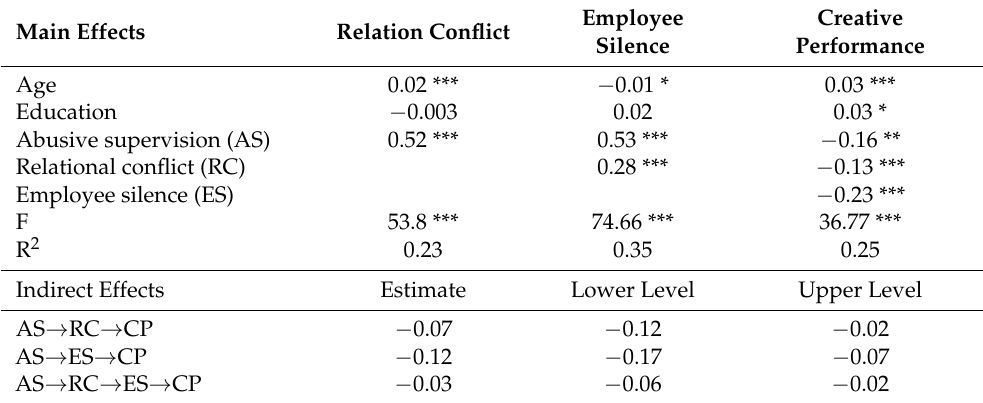
Table 3. Results of Regression Analyses and Bootstrapped Indirect Effect